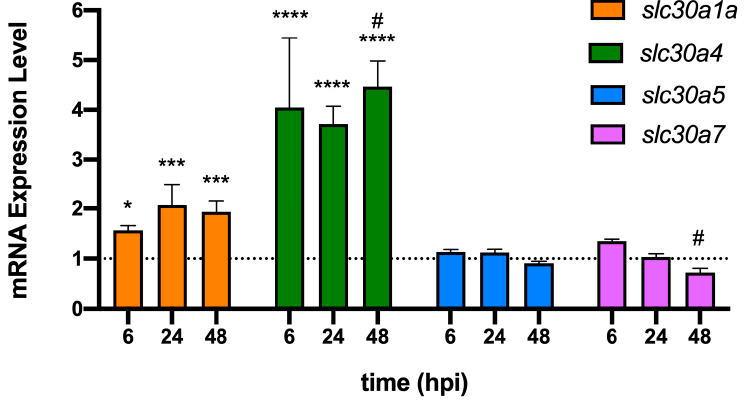
Figure 3. Expression levels of slc30 genes from zebrafish infected with P. aeruginosa . RT-PCR was performed on mRNA extracted from infected zebrafish at 6, 24, and 48 hpi. The dotted line at Y = 1 is the expression level of the genes in uninfected animals (control). Data are means ± SD of three independent experiments, and statistical analyses were carried out by two-way ANOVA and Tukey’s multiple comparison test. Asterisks show statistical differences versus uninfected zebrafish (**** p < 0.0001; *** p < 0.0005; * p < 0.05), and hash signs show statistical differences between 24 hpi